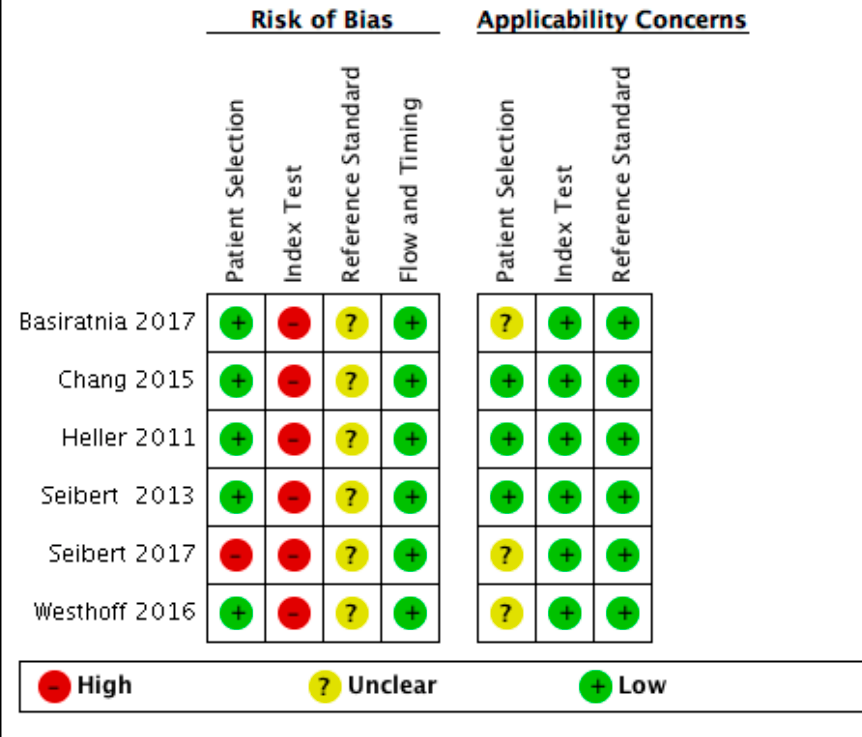
Figure 2. Summary of risk of bias and applicability concerns.